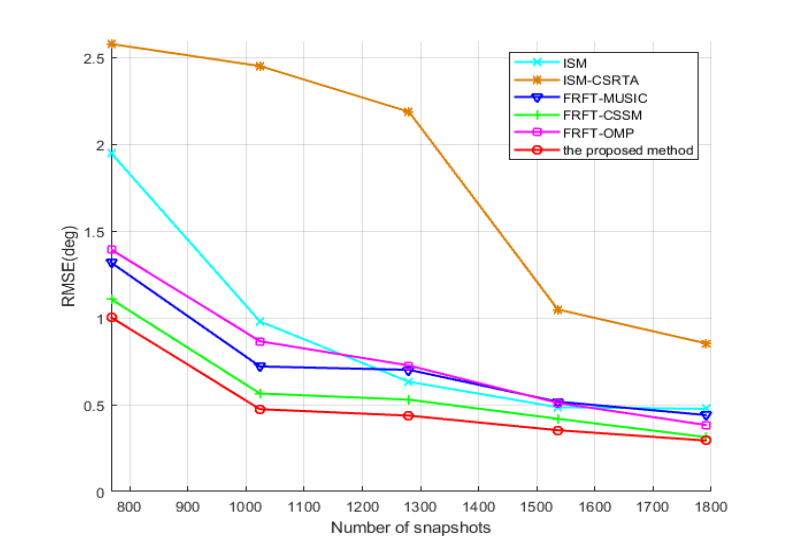
Figure 10. RMSE of the DOA estimations vs. the number of